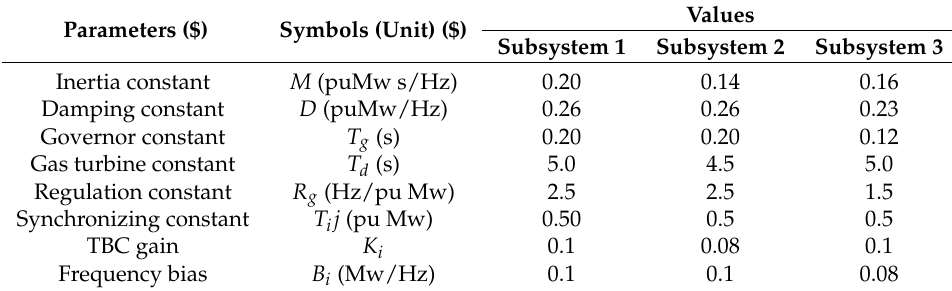
Table 1. Parameter